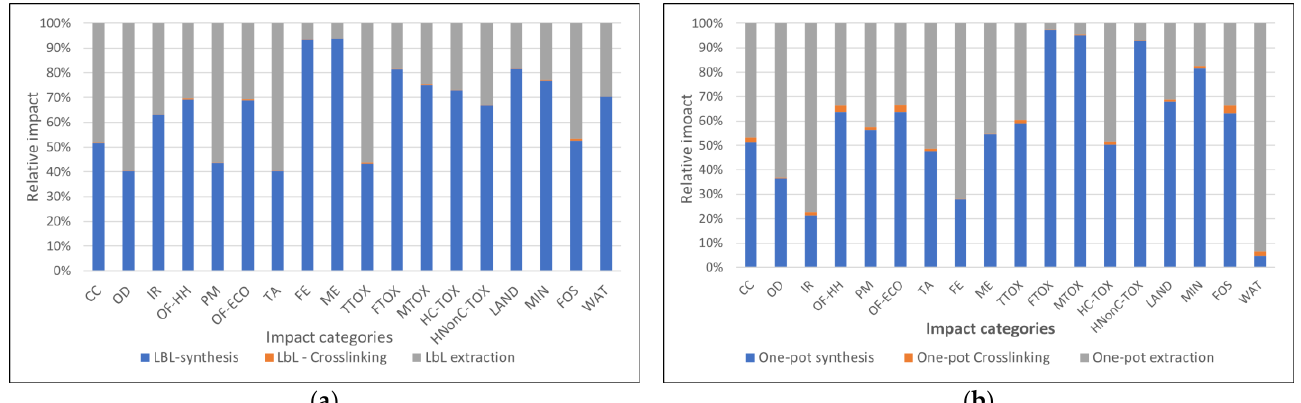
Figure 4. Environmental impacts induced by the synthesis steps ( a ) . LbL deposition; ( b ) One-pot synthesis).